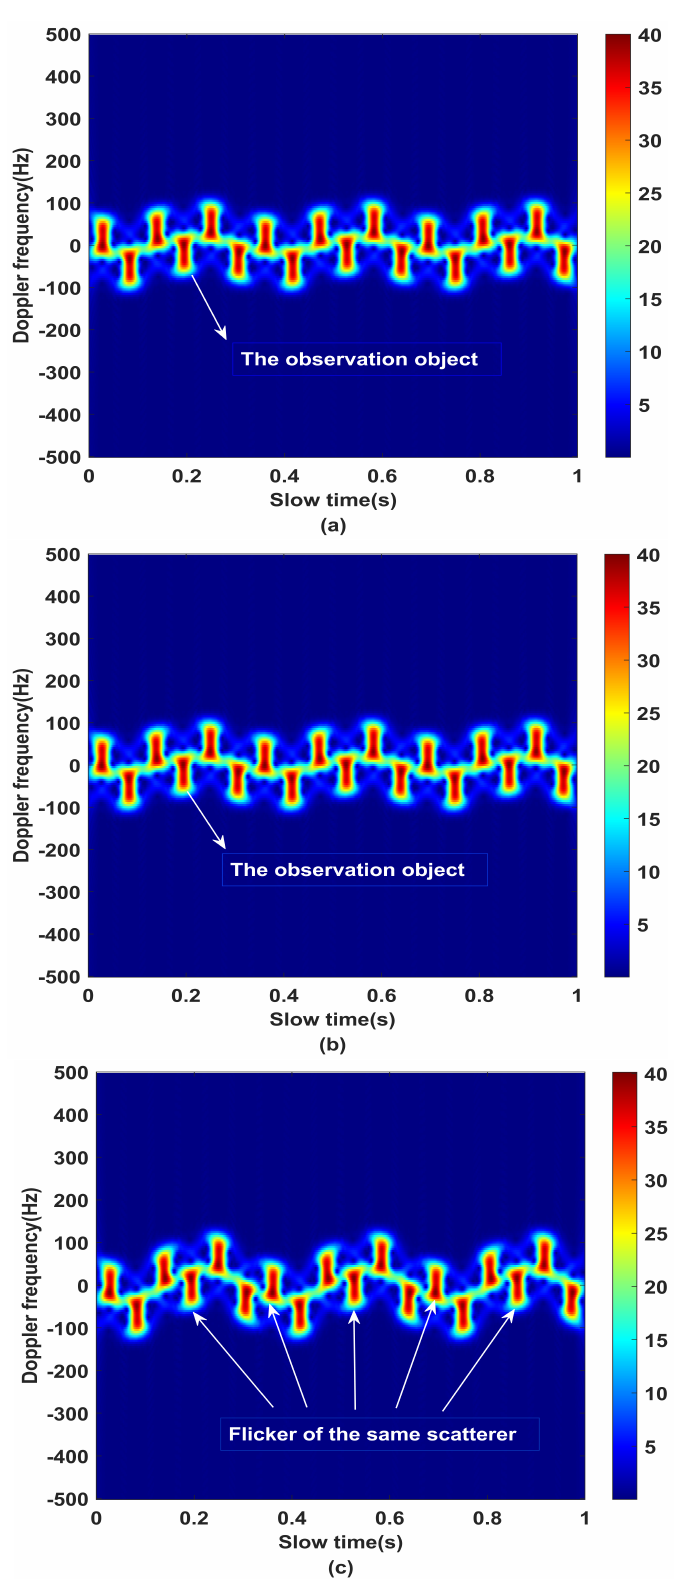
Figure 7. Time-frequency diagram of echo signal after iterative compensation: ( a ) obtained by first iteration, ( b ) obtained by second iteration, ( c ) obtained by third